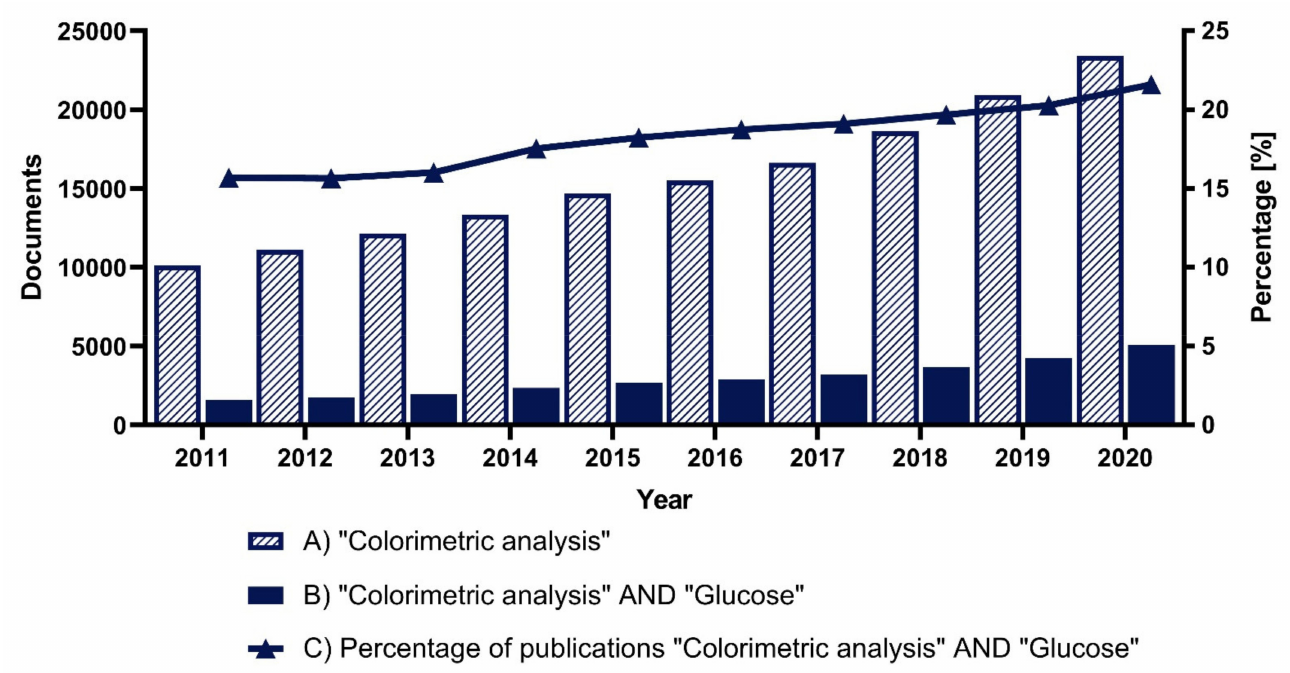
Figure 2. Analysis of the number of documents in Scopus over the last ten years: ( A ) using the search term “Colorimetric analysis”, ( B ) using the search terms “Colorimetric analysis” AND “Glucose”, ( C ) percentage of papers found using the term “Glucose” in the category “Colorimetric